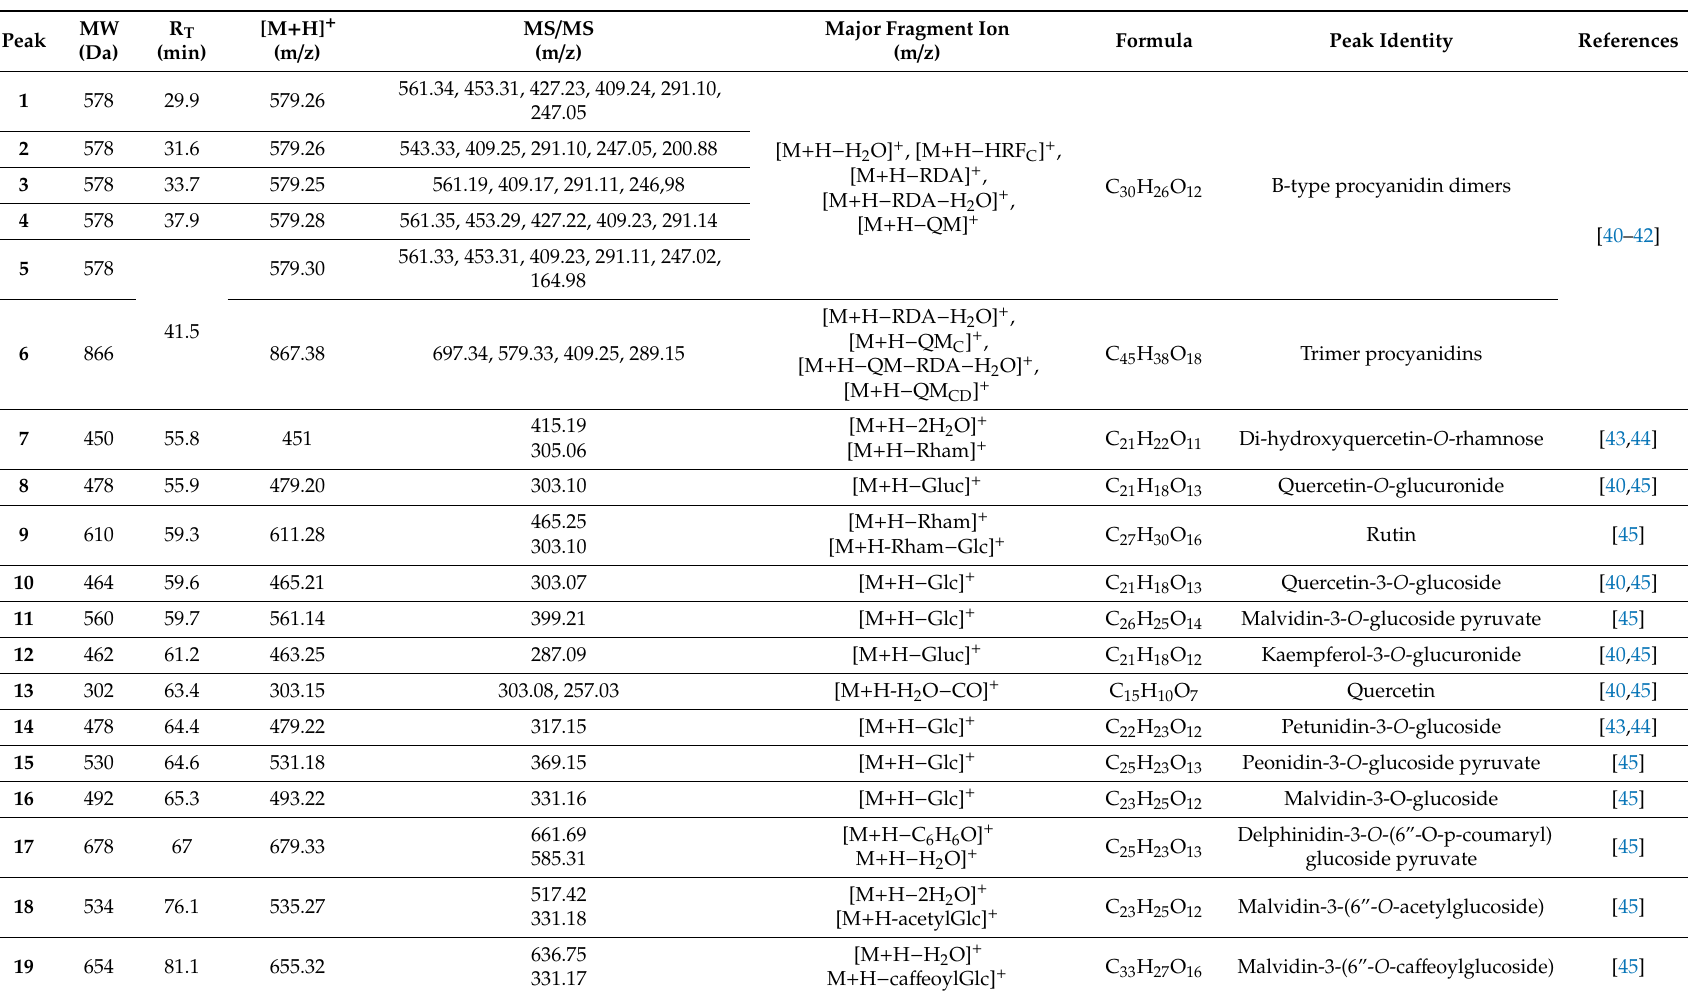
Table 2. ESI-MS / MS of the phenolic compounds identified in the crude Vitis vinifera L.